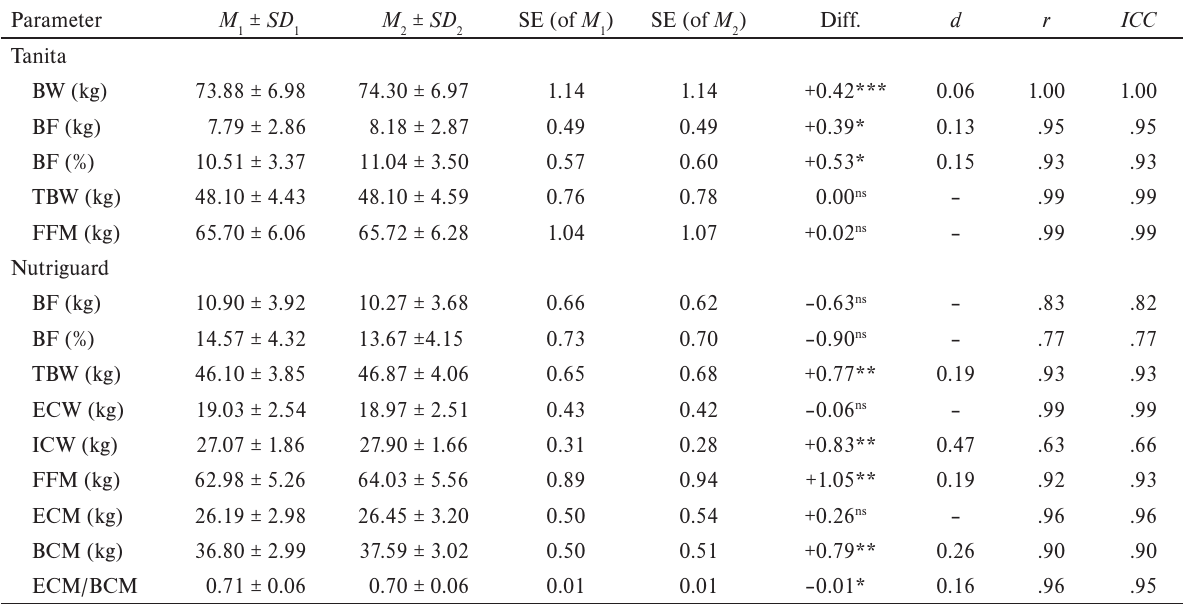
Descriptive results of the monitored parameters measured before and after the intake of fluids